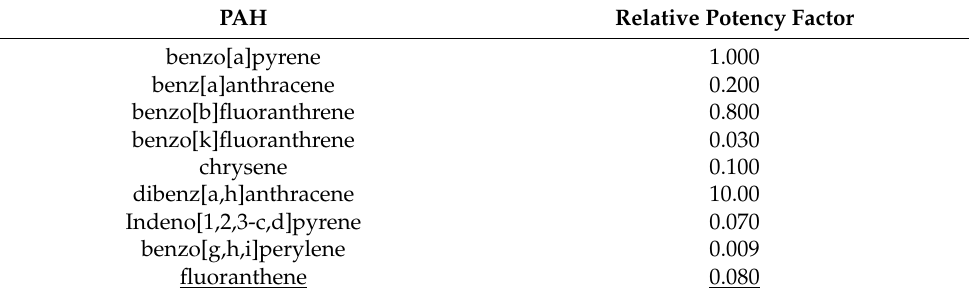
Table 4. Relative potency factor, (EPA, 2010) [35]. PAH Relative Potency